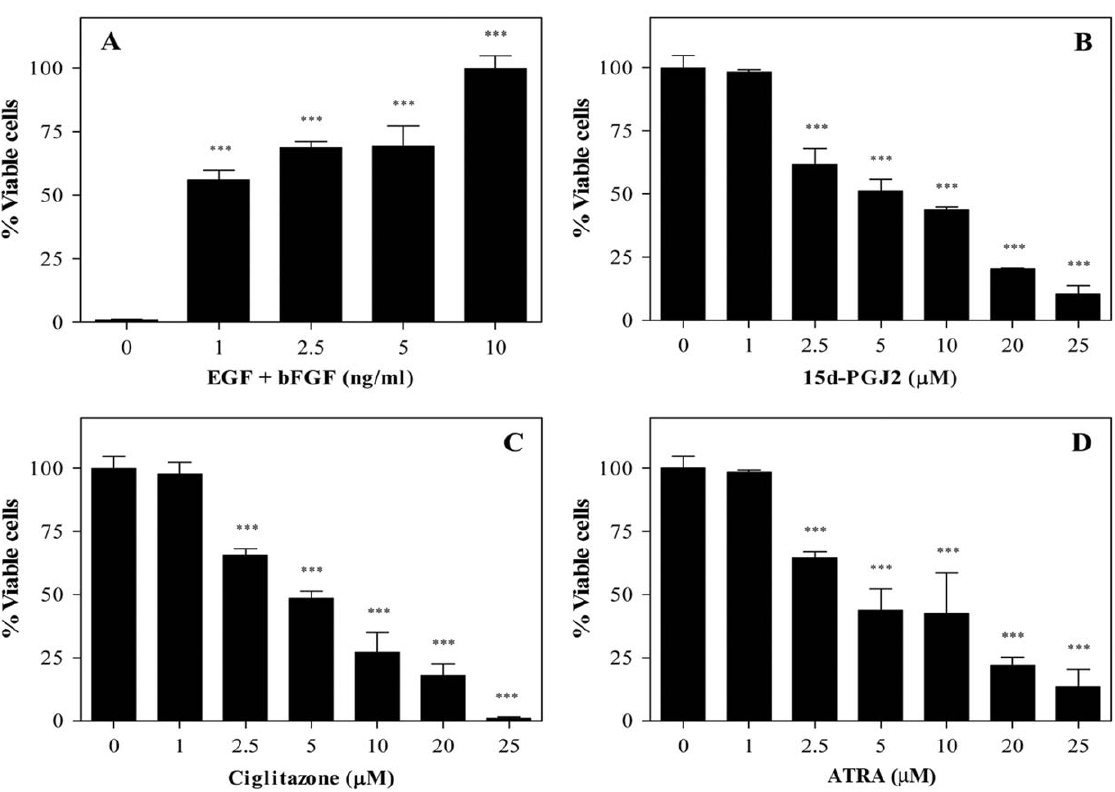
Figure 2. Inhibition of NSC proliferation by PPAR c agonists. NSCs dissociated from 7–10 day old neurospheres were cultured in 96 well tissue culture plates (1 6 10 4 /0.2 ml/well) in NBM + B27 with different doses of EGF + bFGF (A) or 10 ng/ml EGF + bFGF in the presence of different doses of 15d- PGJ 2 (B), ciglitazone (C) and ATRA (D). The cell proliferation/viability was measured by WST-1 assay. The values are means of triplicates 6 SD and the p values are expressed as *(p , 0.05), **(p , 0.01), and ***(p , 0.001). The figure is a representative of three independent